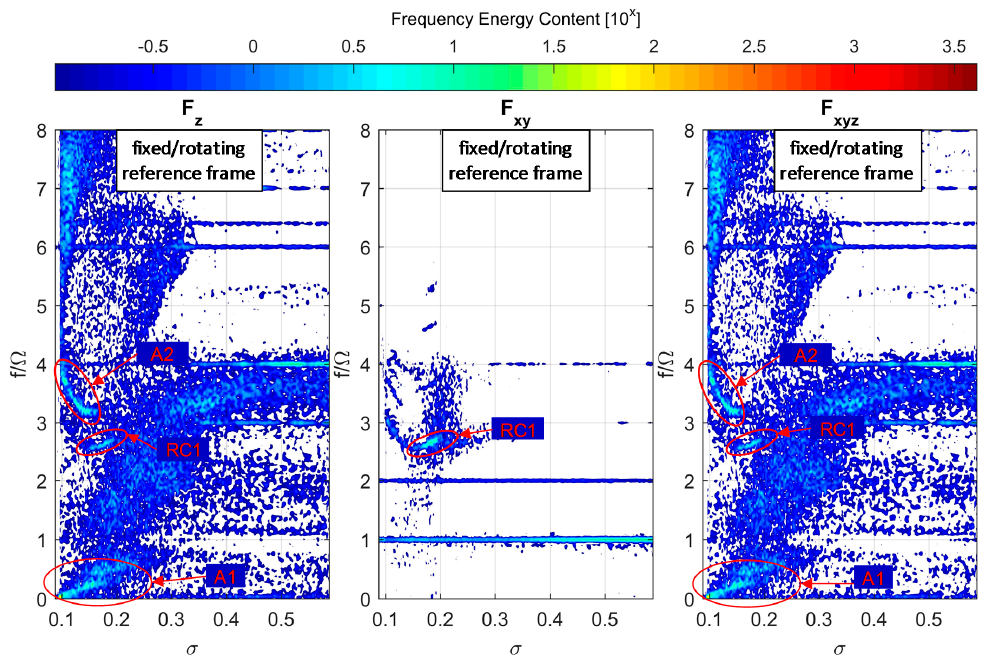
Figure 13. Frequency energy content [N 2 · s] of the force along the axis ( F z ) , its perpendicular component (cid:3435)(cid:1832) (cid:3051)(cid:3052) (cid:3439) , and the total force (cid:3435)(cid:1832) (cid:3051)(cid:3052)(cid:3053) (cid:3439) acting on the dynamometer. Red circled phenomena are summarized in Table 8. Int. J. Turbomach. Propuls. Power 2018 , 3 , x FOR PEER REVIEW